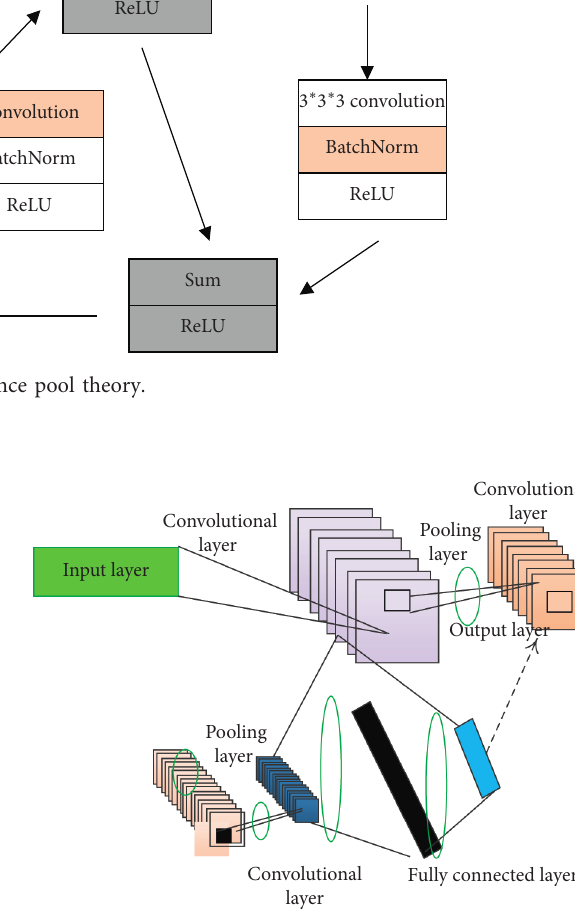
Figure 7: Improved deep separable convolutional network